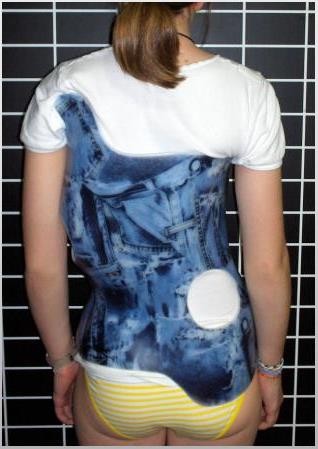
(Long brace) (Thoraco-lumbar brace with upper thoracic sub axillar extension).